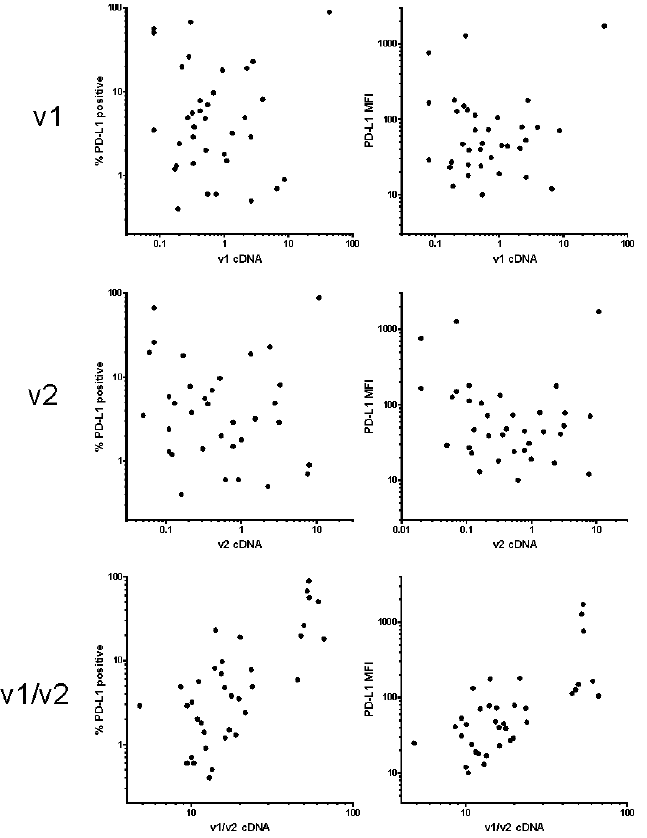
Figure 2. Correlation of PD-L1 cell surface amount with the transcript levels. The amount of PD-L1 on acute myeloid leukemia (AML) blast surface was determined using flow cytometry and expressed as the percentage of positive cells (left column) or as the mean fluorescence intensity (MFI) of the blast population (right column). The relative levels of v1 and v2 transcripts were measured by PCR and normalized to GAPDH.